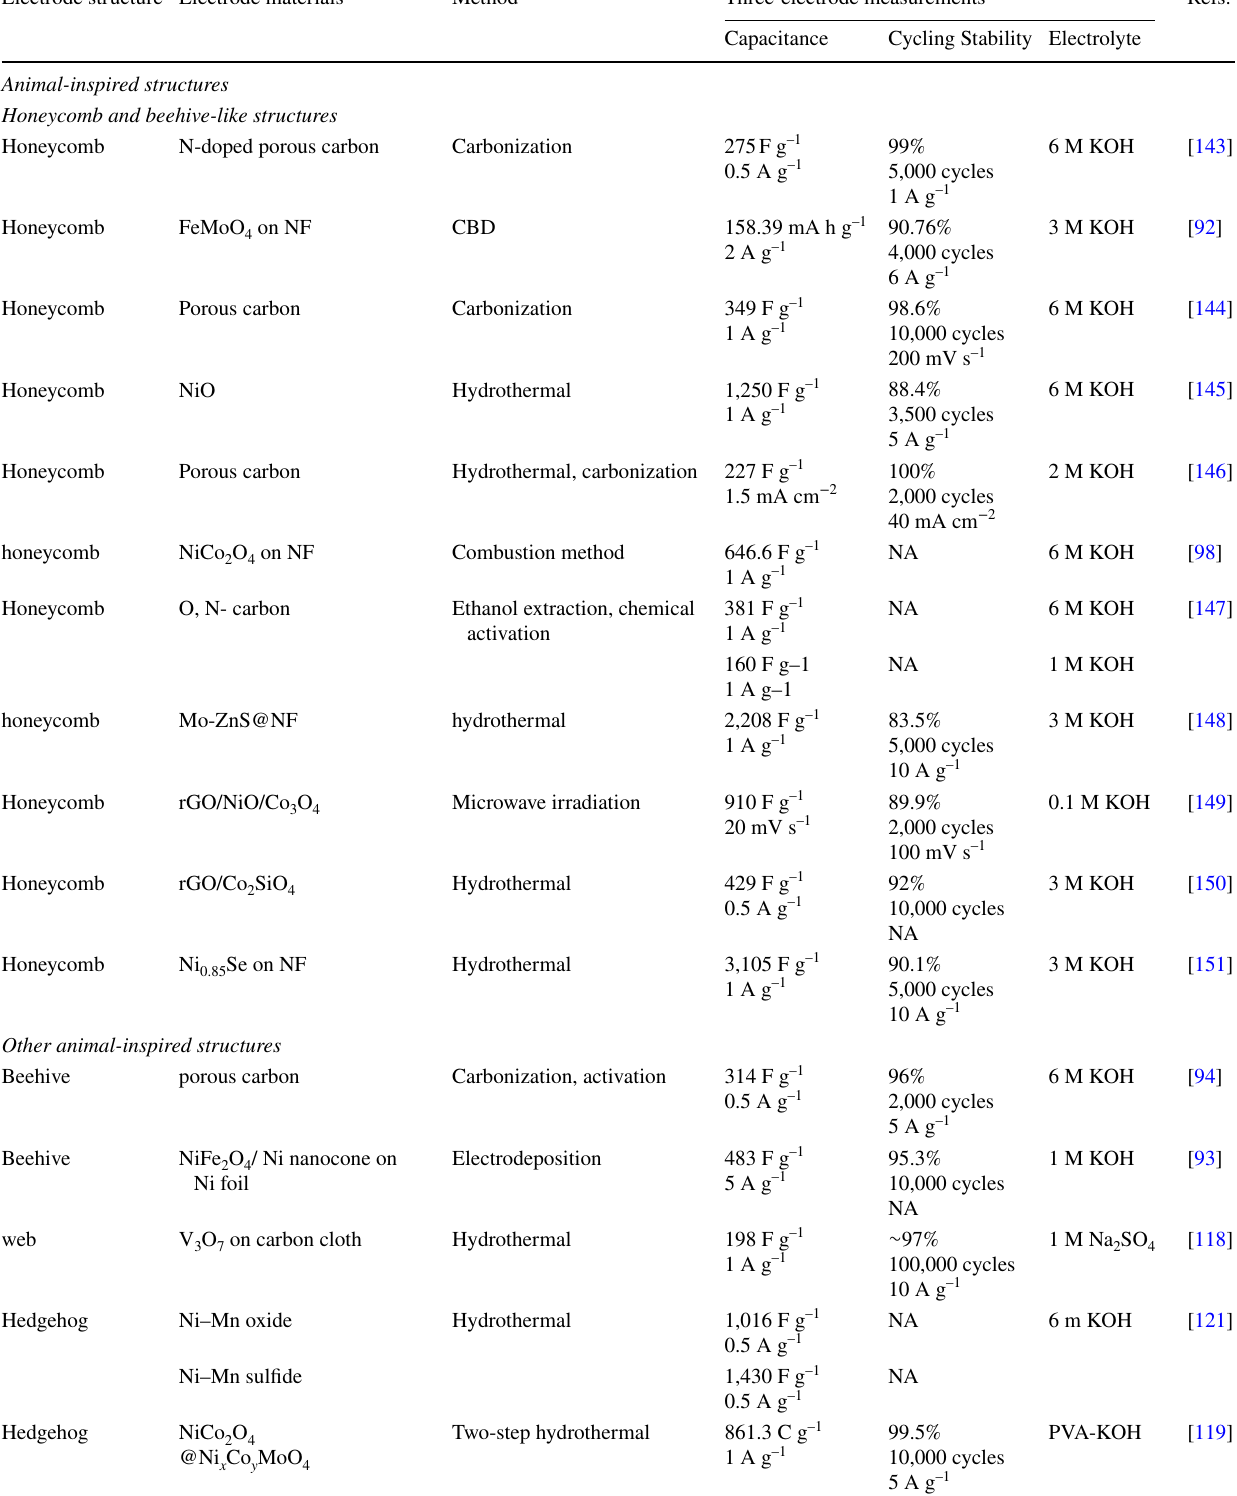
Table 2 Comparison of animal-inspired structures in three-electrode measurements Electrode structure Electrode materials Method Three-electrode measurements Refs. Capacitance Cycling Stability